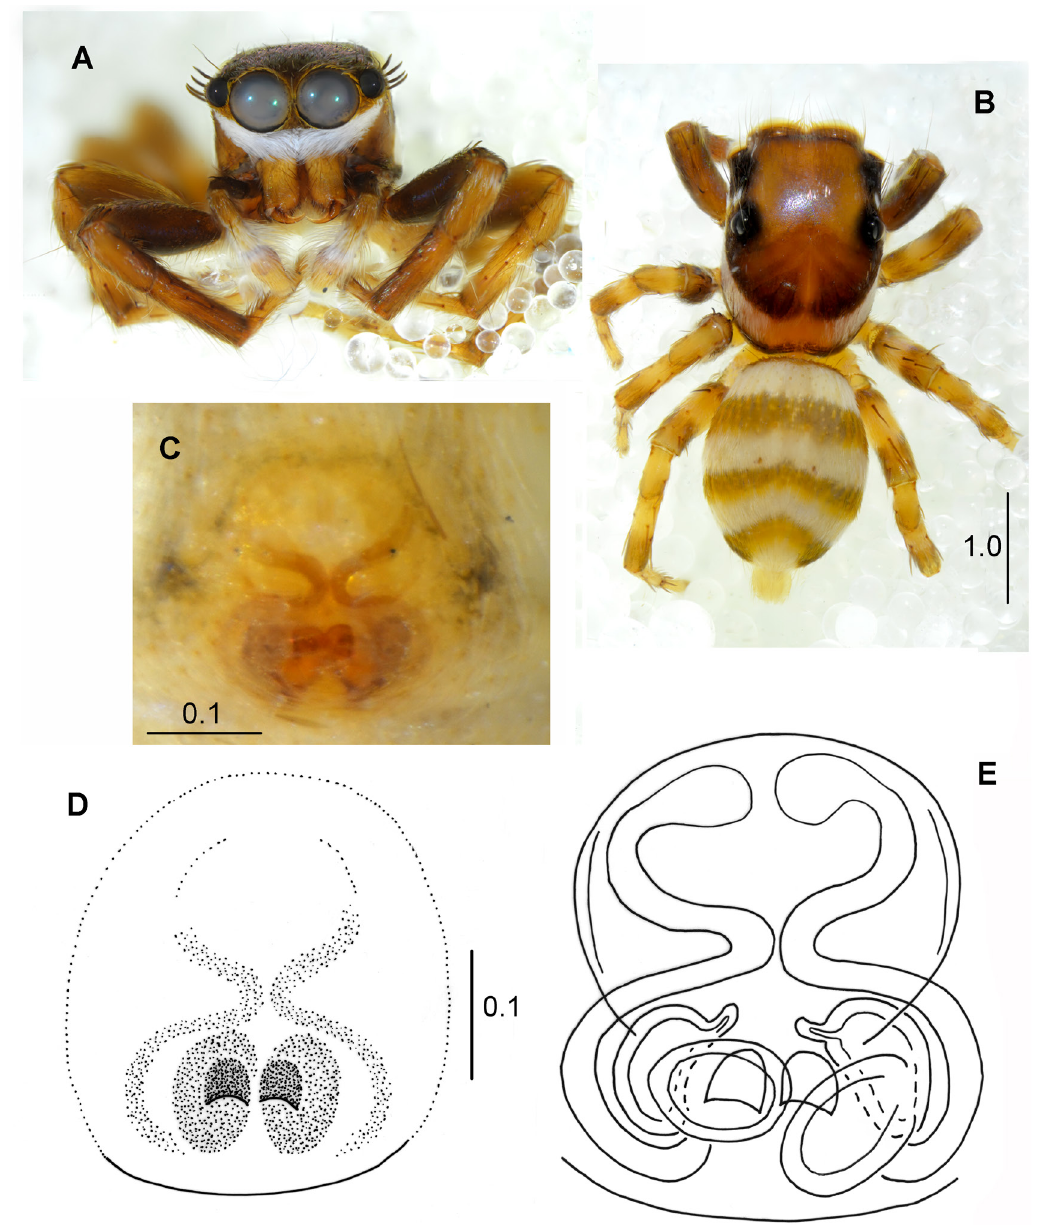
Fig. 42. Parajotus refulgens Wesołowska, 2000, ♂♀ (MNHN). A . Frontal view of male. B . Habitus of female, dorsal view. C–D . Epigyne. E . Internal structure of